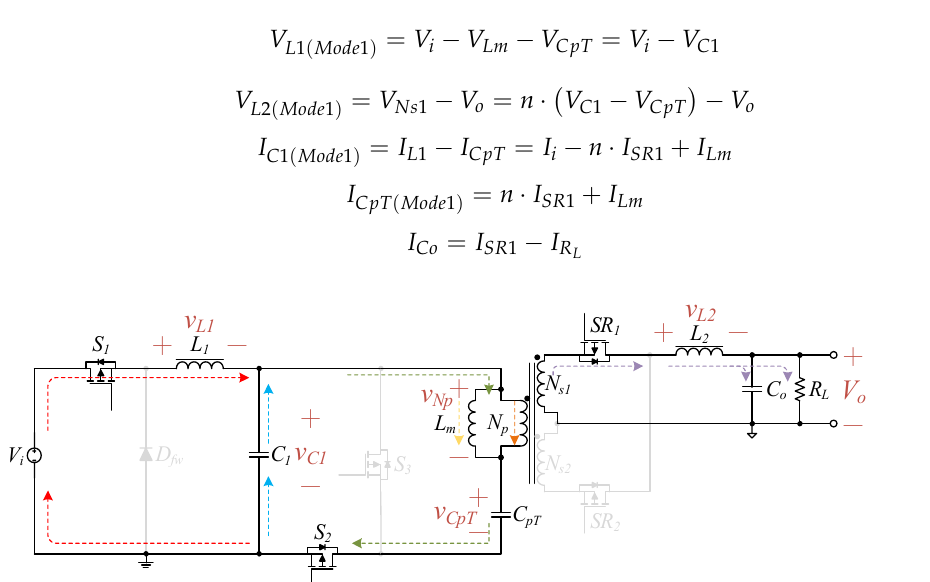
Figure 7. The switches S 1 , S 2 and SR 1 are in the turned-on state.